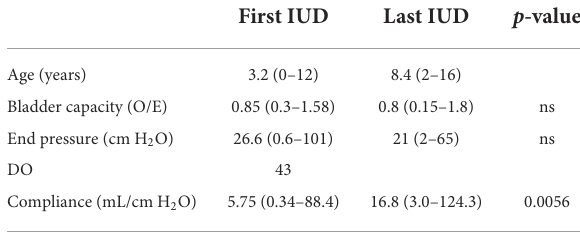
TABLE 2 Comparison of data from first and last invasive video urodynamics (IUD) for 54 patients on whom multiple IUDs were